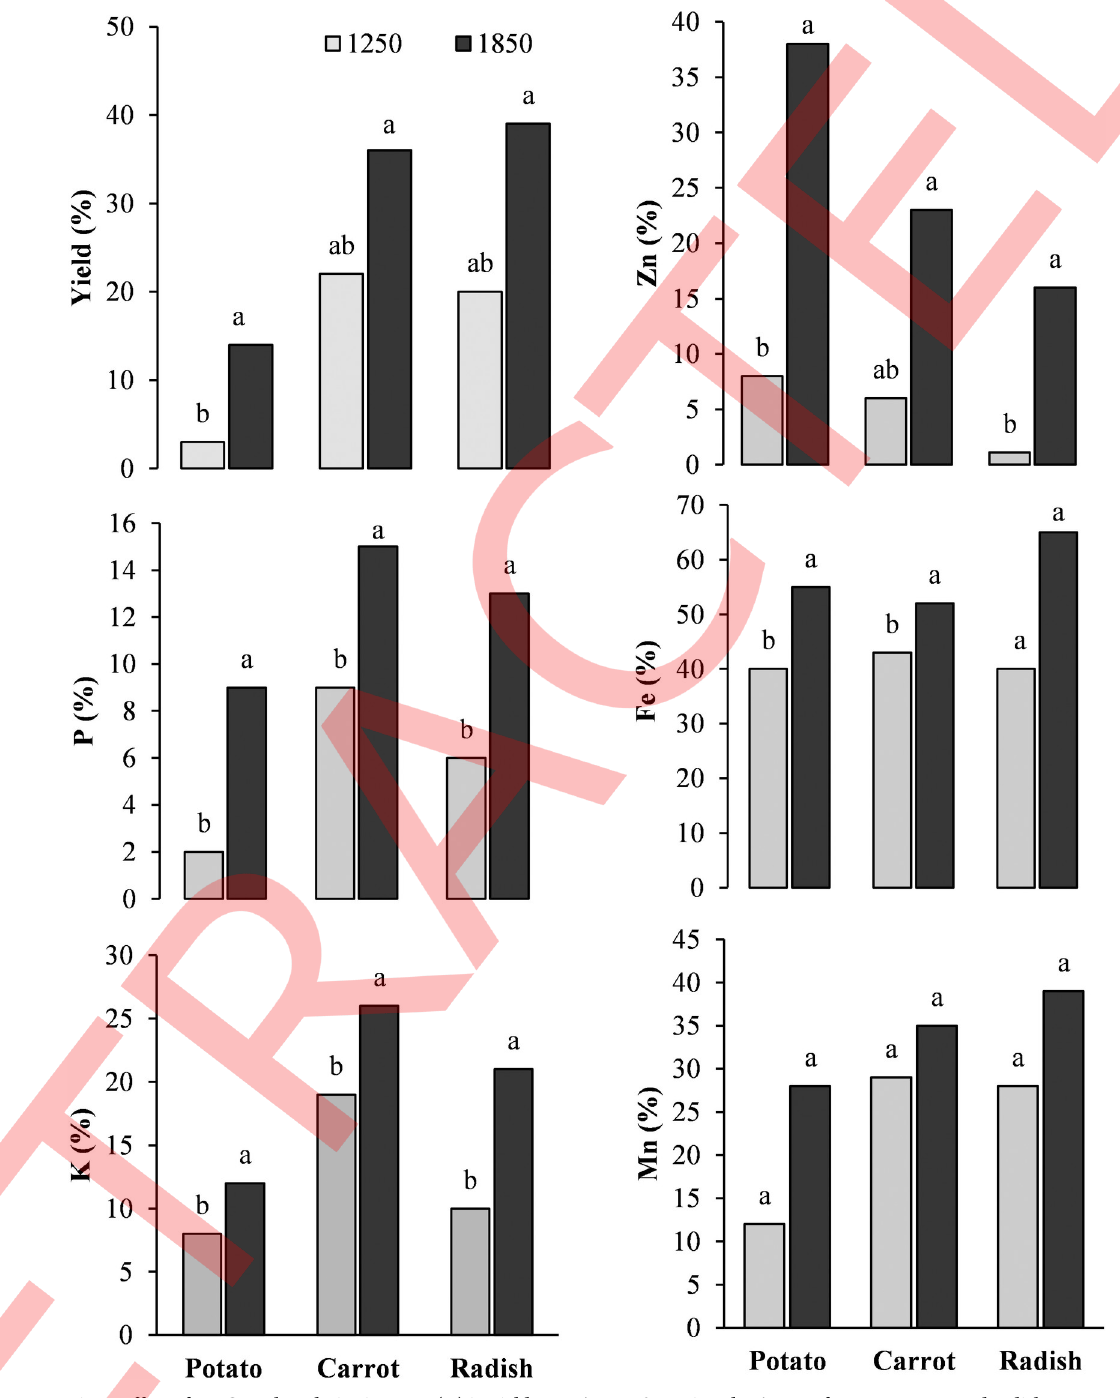
Fig 3. Effect of PMC on the relative increase (%) in yield, P, K, Zn, Fe & Mn in tuber/roots of potato, carrot, and radish. Compost levels 0 (Control), 1250 kg compost ha -1 (PMC1) and 1850 kg compost ha -1 (PMC2). The column shows the means of three replications while bars show standard error. Means sharing similar letter (s) do not differ significantly at P � 0.05 according to the LSD test.